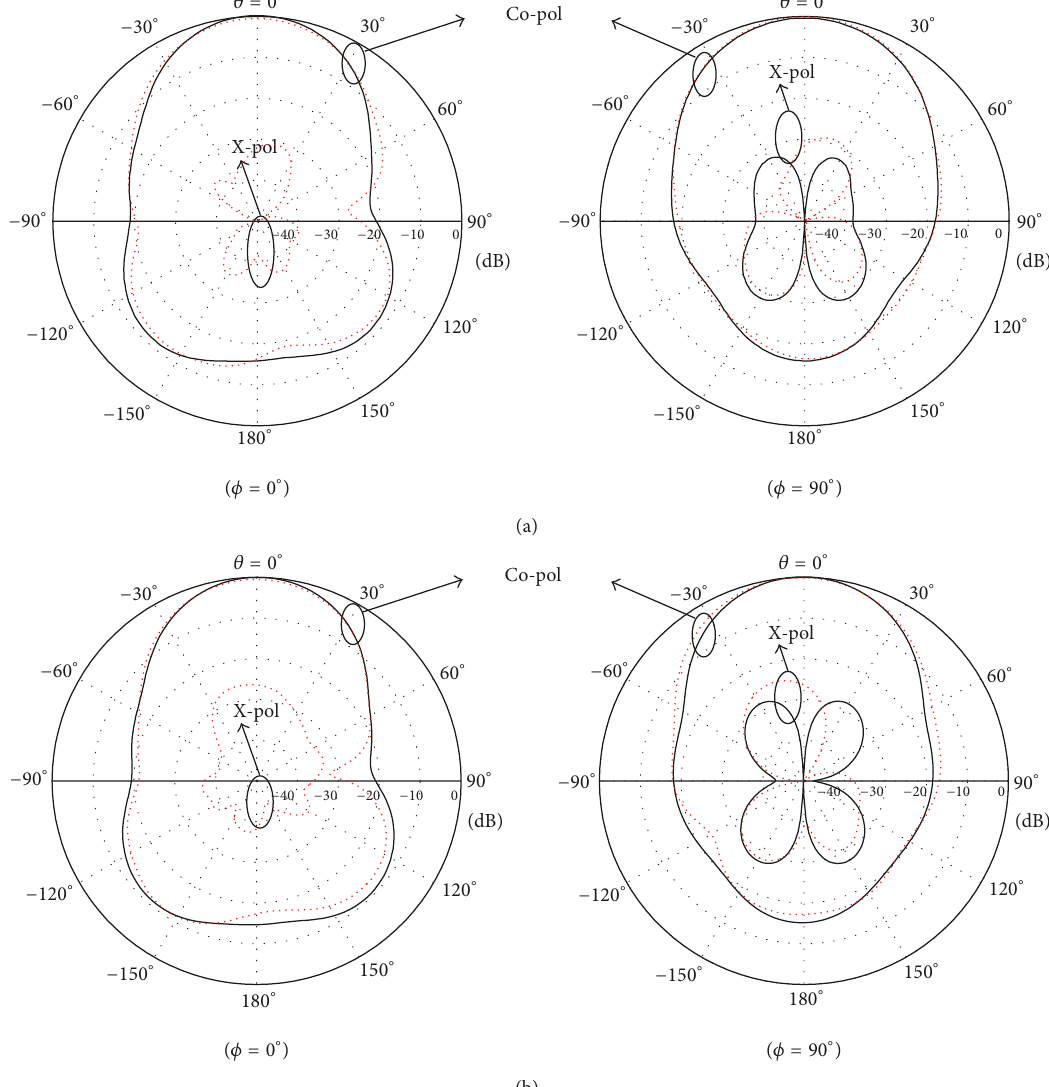
Figure 10: Measured and simulated radiation patterns of antennas II and III at 5 GHz. (a) Antenna II. (b) Antenna III.